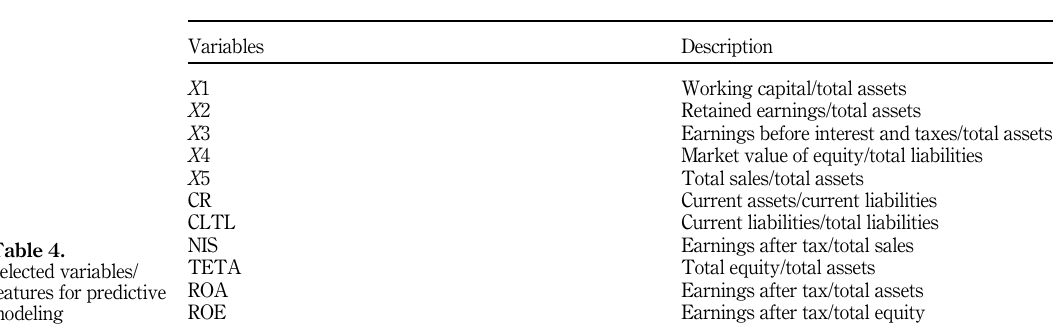
Table 3. Machine learning models for this